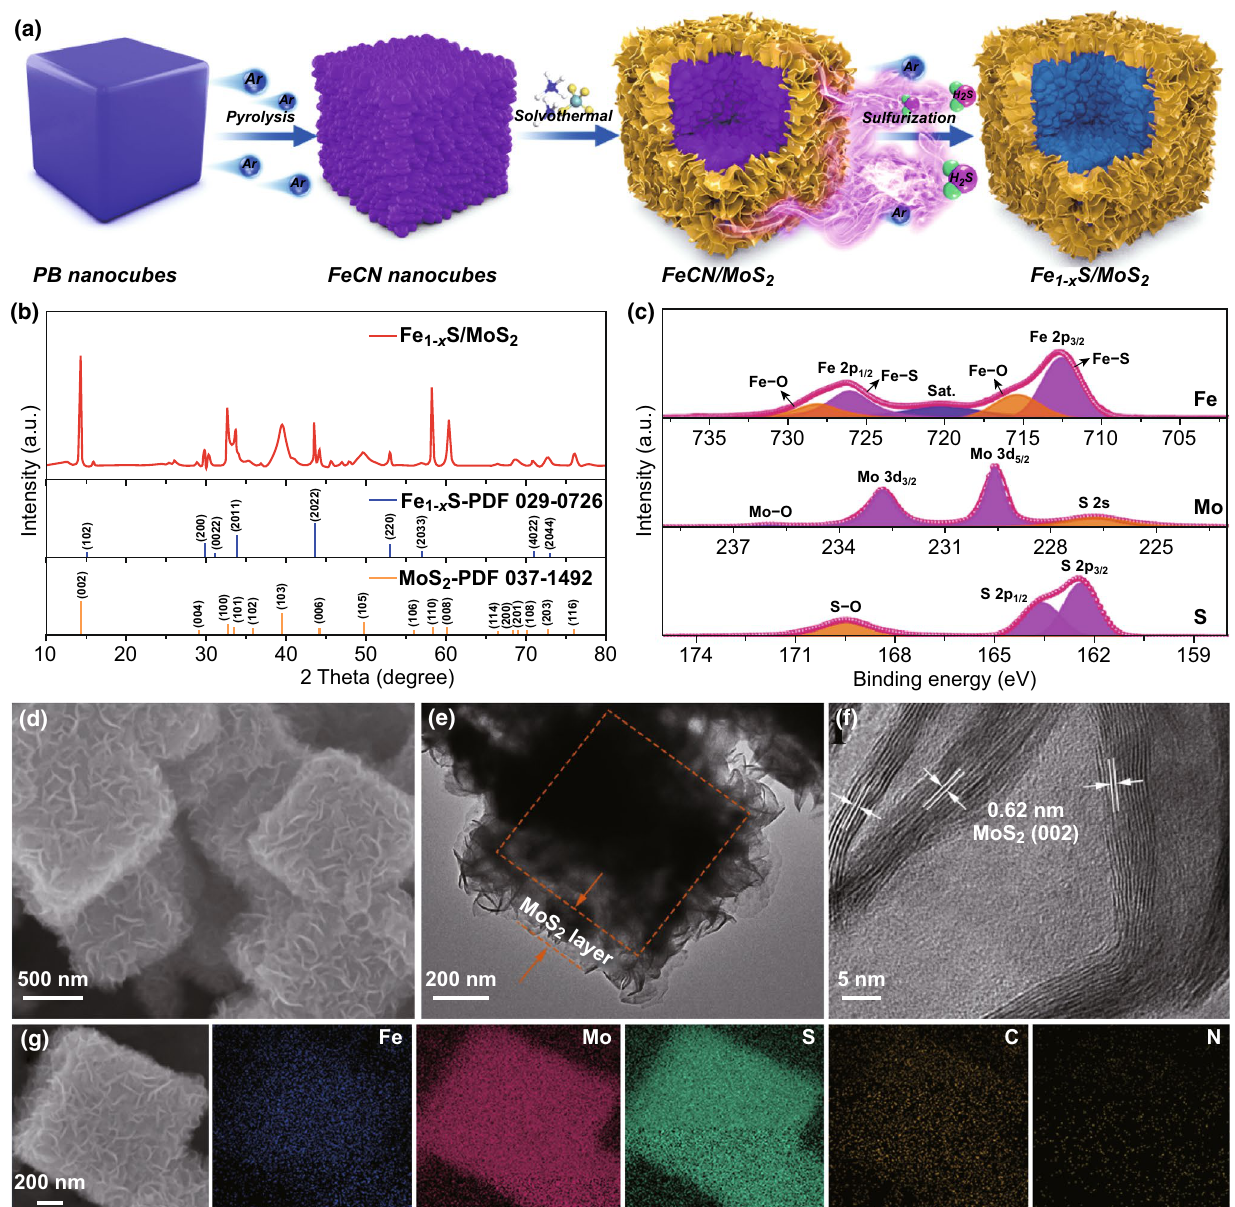
Fig. 1 a Schematic illustration of the synthesis process for Fe 1− x S/MoS 2 nanocomposite. b XRD pattern and c high-resolution XPS spectra (Fe 2 p , Mo 3 d , and S 2 p ) of Fe 1− x S/MoS 2 composite. d SEM, e TEM and f HRTEM images of Fe 1− x S/MoS 2 composite. g Element mappings of the Fe 1− x S/MoS 2